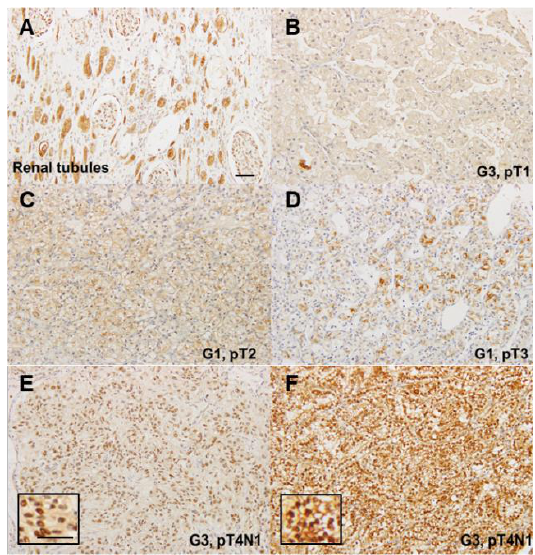
Figure 1. Immunohistochemistry of CLDN4 in renal cell carcinomas. ( A ) Non-tumoral renal tissue. Immunoreactivity of CLDN4 is observed in the cytoplasmic membrane and cytoplasm. ( B – F ) Expression of CLDN4 in renal cell carcinomas. ( B – D ) Faint membranous and scattered cytoplasmic staining of CLDN4. ( E , F ) Diffuse nuclear staining of CLDN4. Insert, high magnification image. Scale bar, 100 μm. G, histological grade; pT, local progression of primary tumor; pN, lymph node metastasis. Table 1. Expression of membranous CLDN4 in 202 cases of renal cell carcinomas.